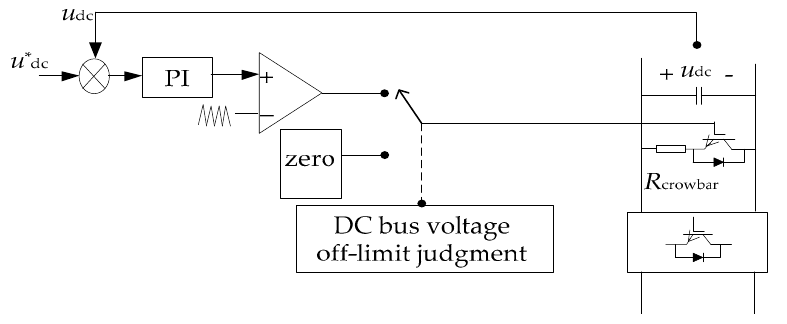
Figure 2. Control principle of relieving circuit on dc bus side.